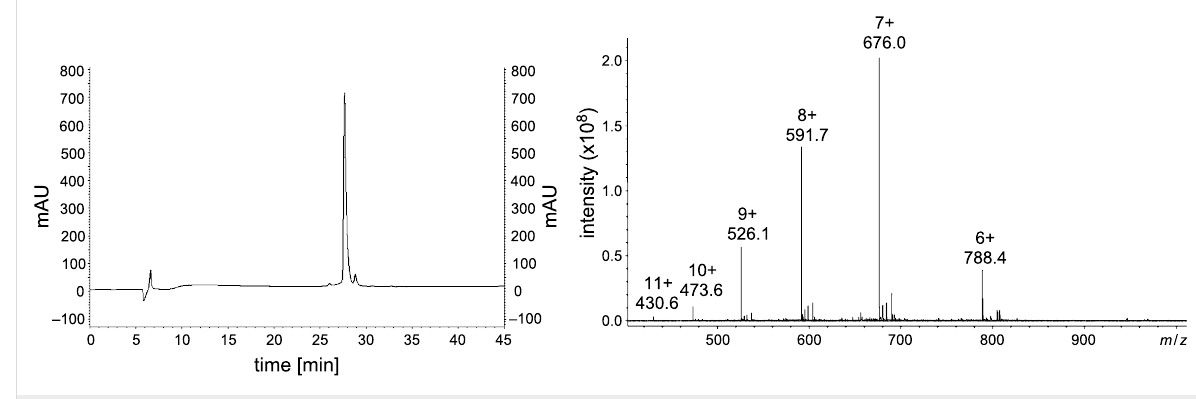
Figure 5: Chromatogram and ESI-MS of purified Cym2-GFL-(sC18) 2 . The gradient was 10 → 60% acetonitrile in water over 45 min.